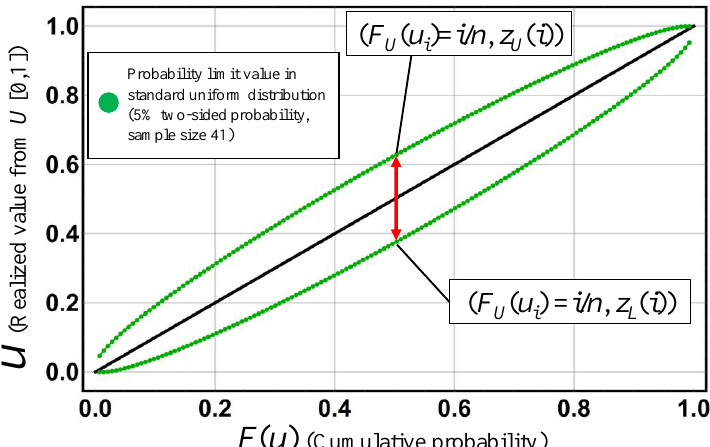
Figure 4. Probability representing function of the Gumbel distribution χ α ( u ) fitted to the sample of −log 10 (2α min ). In this study, 5000 α min was sampled to secure the stability of the distribution of α min .